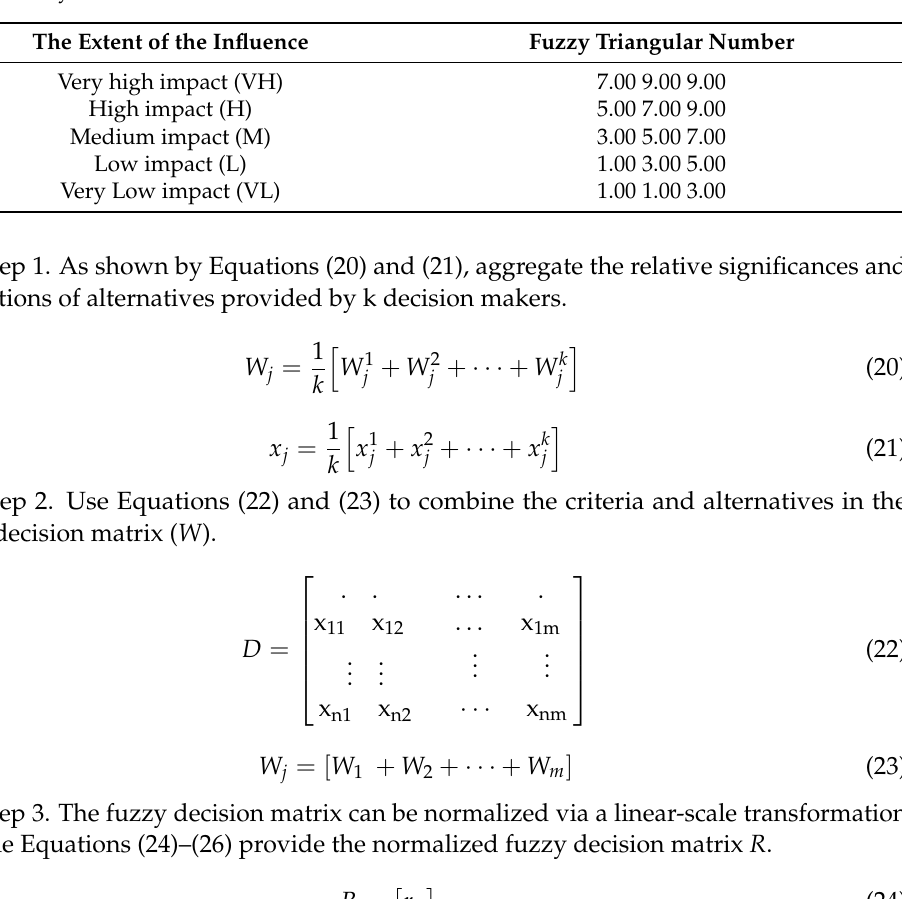
Table 3. Fuzzy TOPSIS